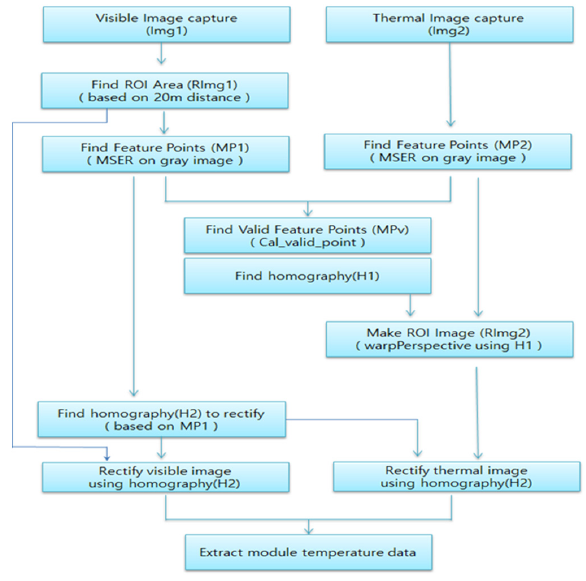
Figure 2. Flowchart of the proposed visible and thermal image matching and rectification algorithm.